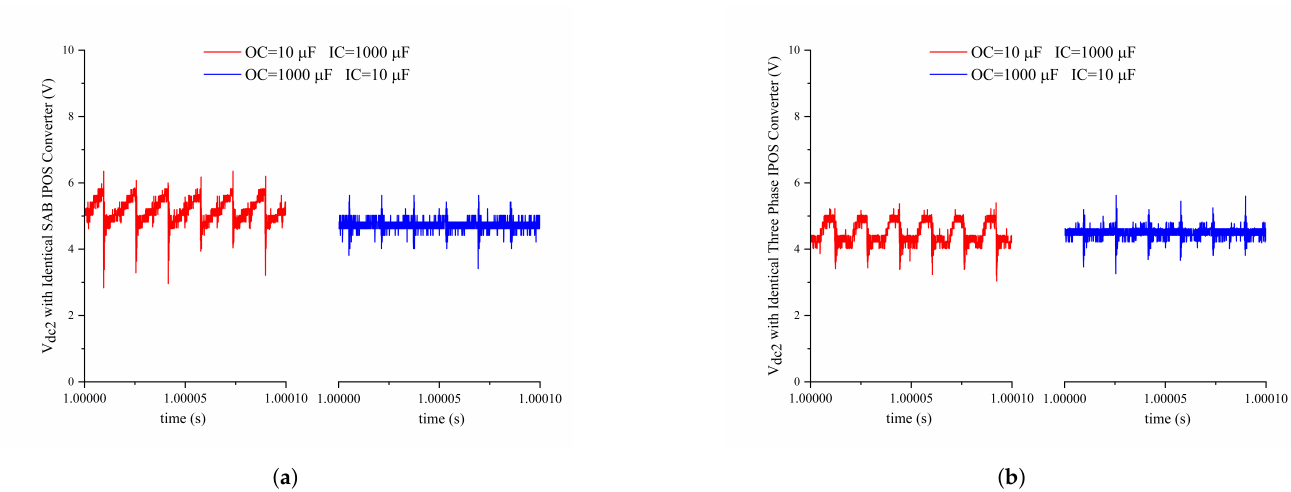
Figure 11. Comparison of the waveform of V dc1 under different situations. ( a ) V dc1 with Identical SAB IPOS Converter; and ( b ) V dc1 with Identical Three Phase IPOS Converter.